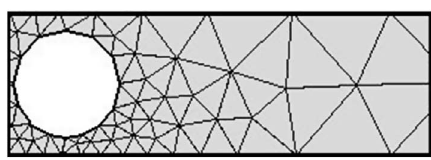
Figure 5. FEM triangular fl at mesh with a high growth factor adapted to the scatterers